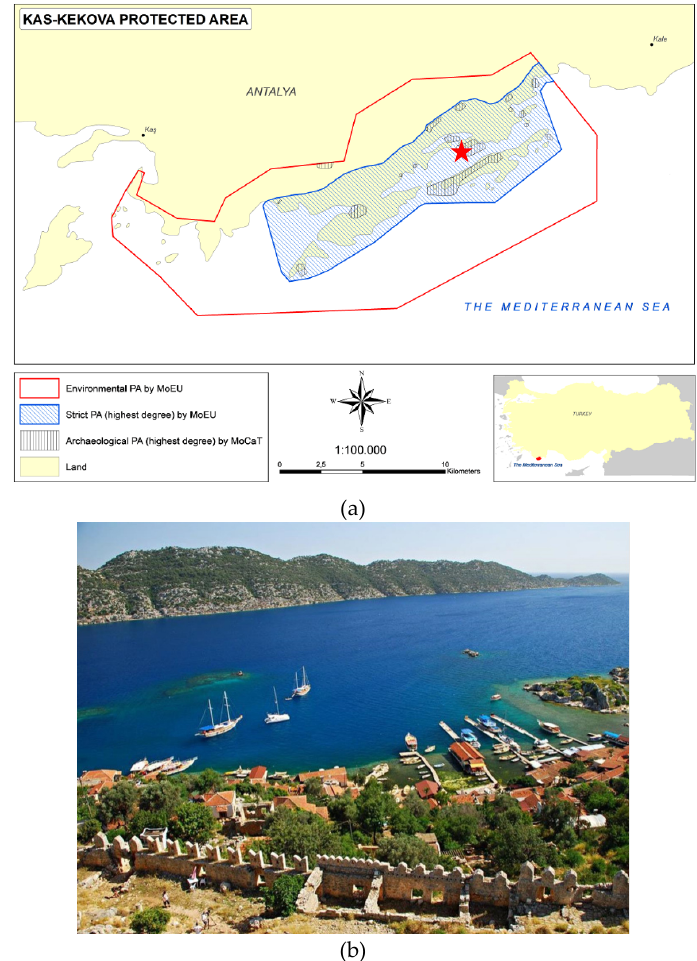
Figure 1. ( a ) The study site and the registered protected area (PA) boundaries (upper left coordinates: Lat: 36.250 Lon: 29.630; lower right coordinates: Lat: 36.060 Lon: 29.940) [35]. The red star denotes